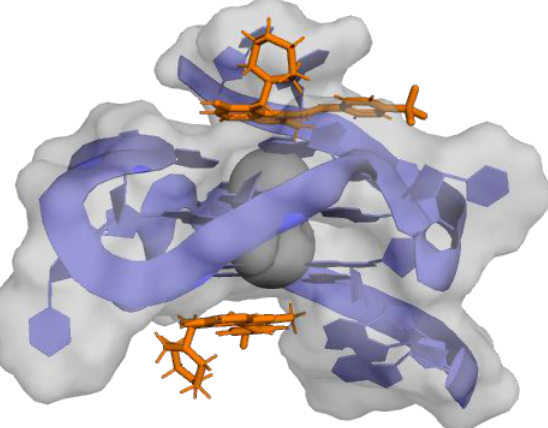
Figure 12. Schematic representation of Compound 49 (colored sticks) in a 2:1 complex with a c-MYC G4 structure (PDB ID: 5W77).